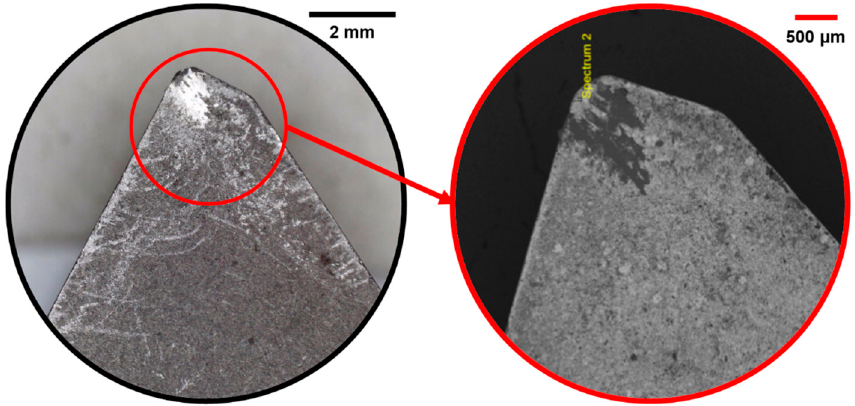
Figure 5. Wear of DLC-coated WC tool inserts shown on the microscopic image are encircled and the SEM image is shown on the right-hand side. Table 4. Elemental composition of tungsten carbide (WC) substrate.